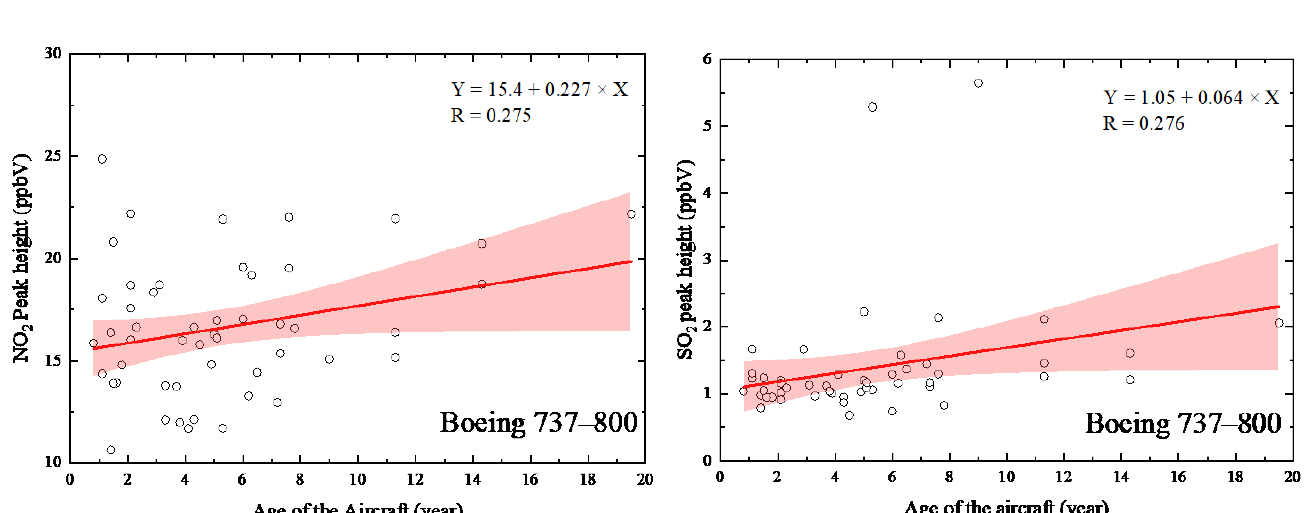
Figure 8. Boxplots of NO 2 and SO 2 peak heights for aircraft emissions data for various aircraft types.